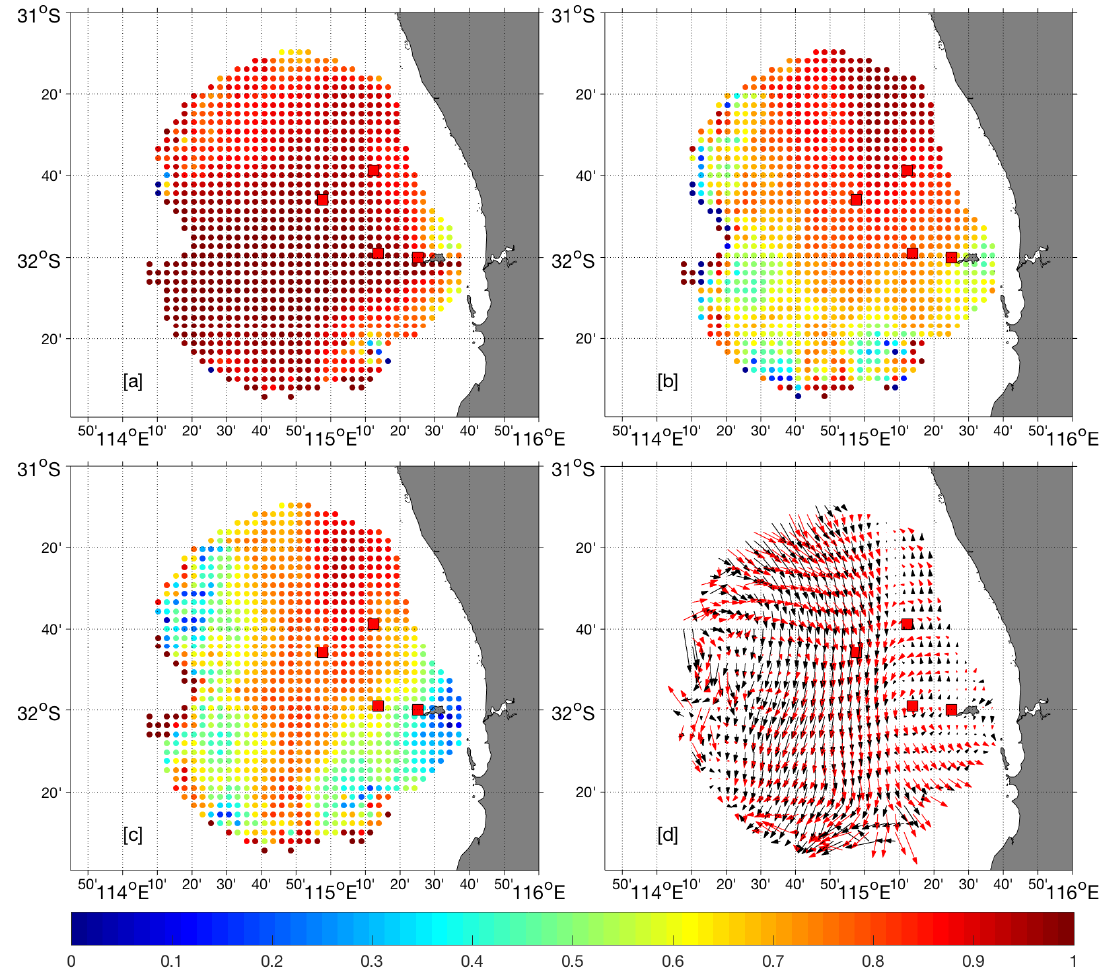
Figure 5. Spatial distribution of correlation between WERA and merged SeaSonde–WERA radial current maps, and corresponding time-averaged current patterns: ( a ) refers to the zonal component; ( b ) refers to the meridional component; ( c ) is the amplitude of the vector correlation; and ( d ) presents the time-averaged current patterns for the WERA (red arrows) and the merged SeaSonde–WERA (black arrows). Vectors are plotted every two grid points and offset by one grid point to improve readability. Locations of the moorings are marked as red